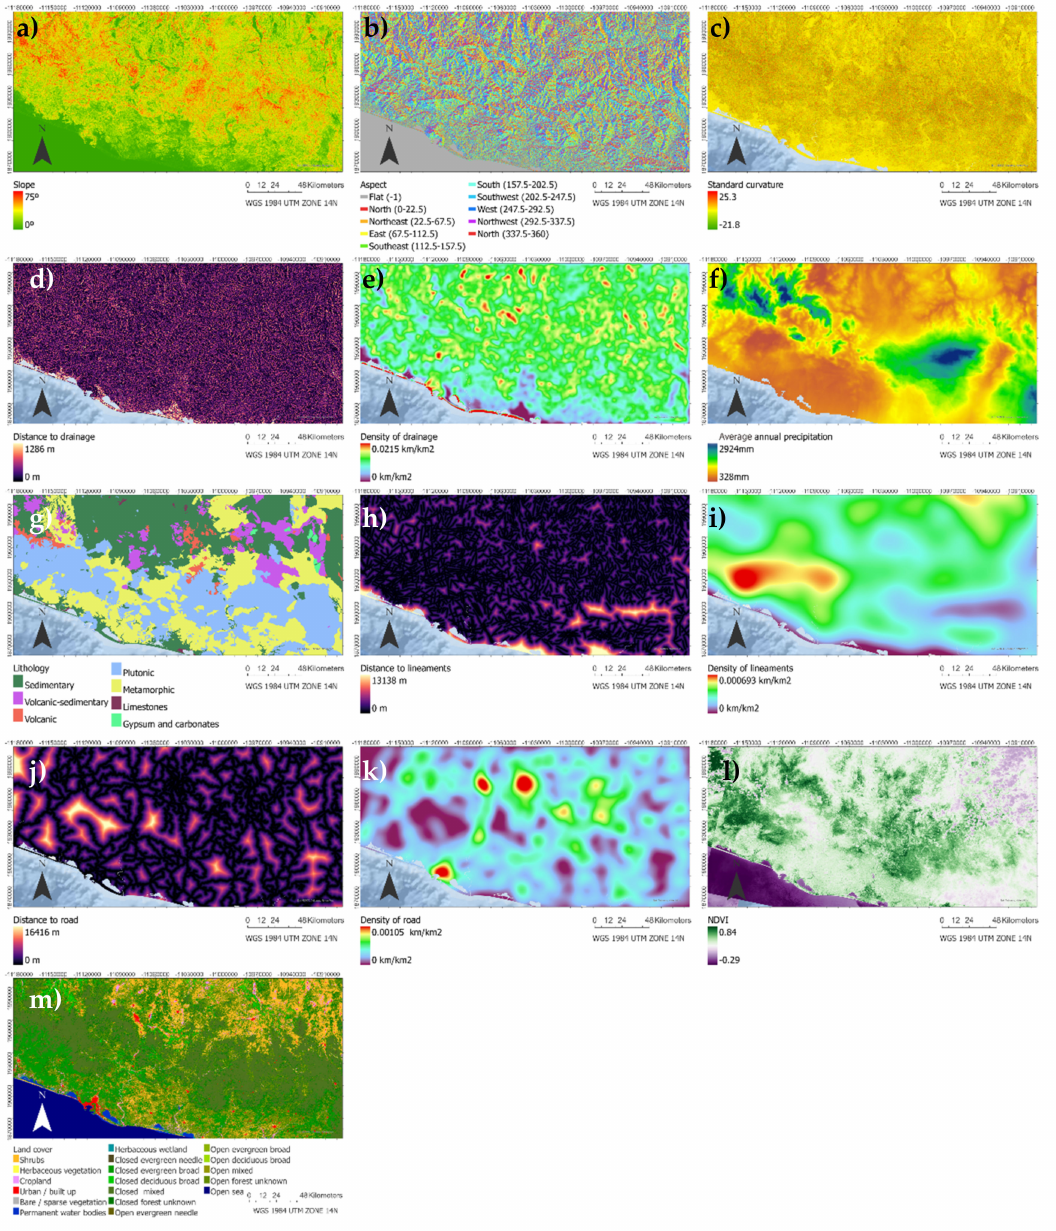
Figure 1. Graphical representation of the explanatory variables. Slope ( a ), aspect ( b ), standard curvature ( c ), distance to drainage network ( d ), density of drainage network ( e ), average annual precipitation ( f ), lithology ( g ), distance to lineaments ( h ), lineament density ( i ), distance to road infrastructure ( j ), road infrastructure density ( k ), NDVI ( l ), land cover ( m ). Shuttle Radar Topography Mission (SRTM) SRTM is a near-global scale digital elevation model, which using radar